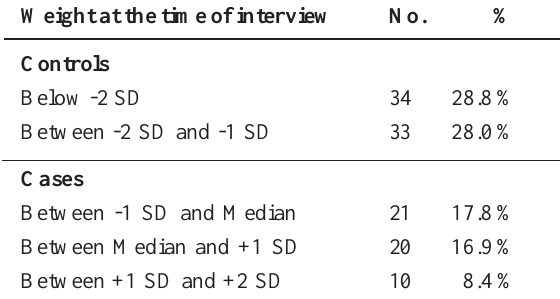
Table 2. Weight for age of cases and controls at the time of the